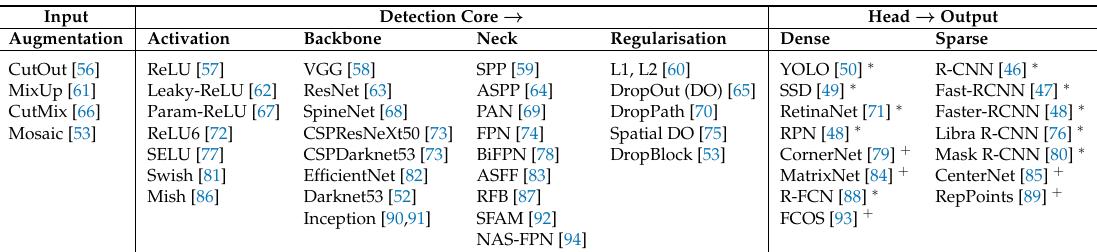
Table 1. State-of-the-art options and techniques to design a Convolutional Neural Network (CNN) based model. From left to right: input towards the